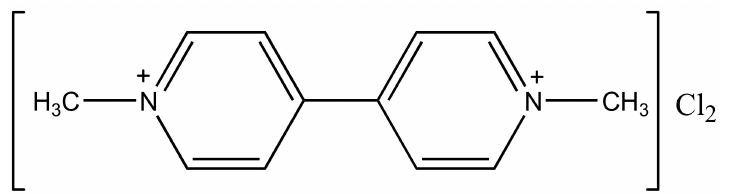
Figure 1. The chemical structure of paraquat (1,1 (cid:48) -dimethyl-4,4 (cid:48) -bipyridinium